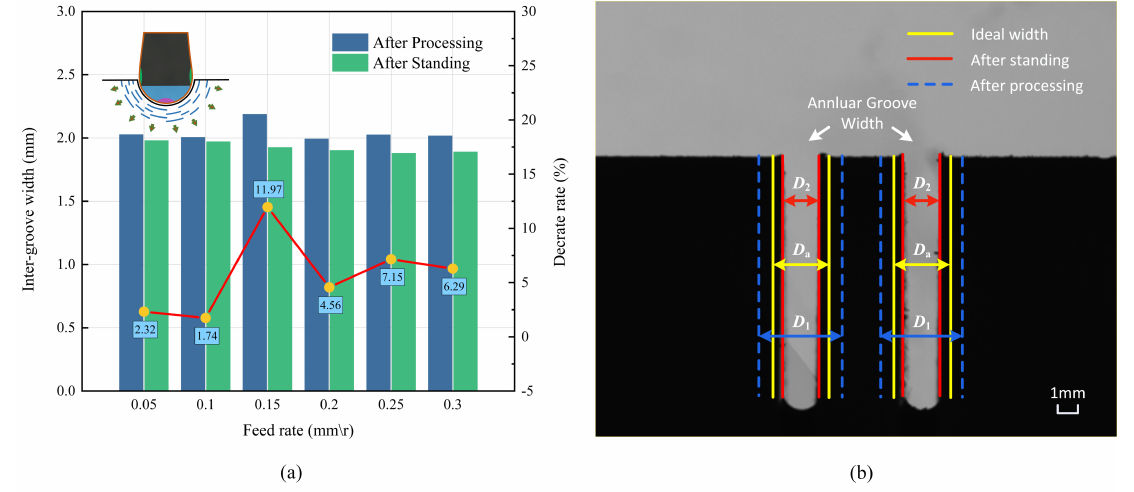
Figure 5. Comparison of groove width of PTFE material after 72 hours of standing: ( a ) comparison of groove width with different feeds and ( b ) time − dependent spring